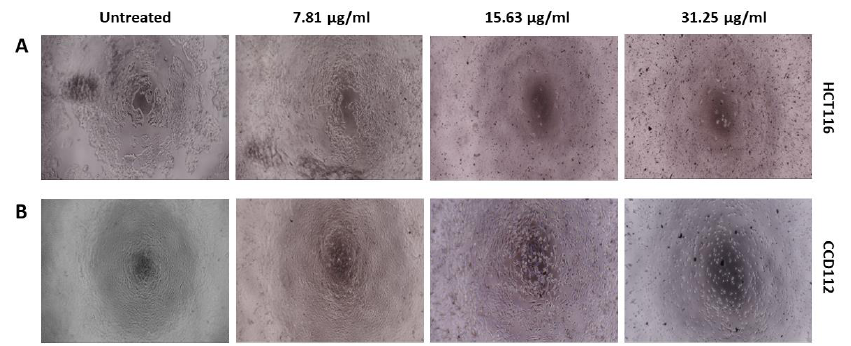
Figure 8. Microscopic examination of ( A ) HCT116 and ( B ) CCD112 cells treated with 7.81, 15.63 and 31.25 µg/mL of AgPCA. Images were captured at magnification of 10X. Nanomaterials 2019 , 9 , x FOR PEER REVIEW